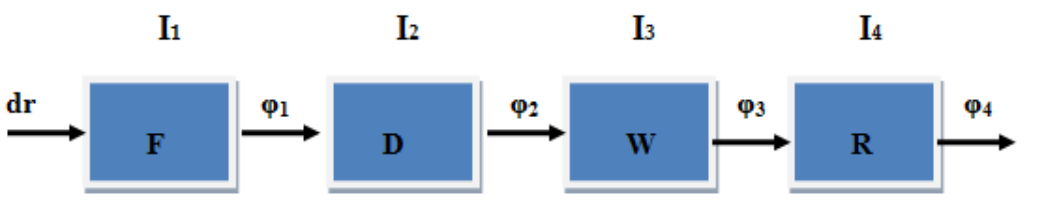
Figure 3. Generic four-echelon serial SC realization for a capacity–inventory management model .